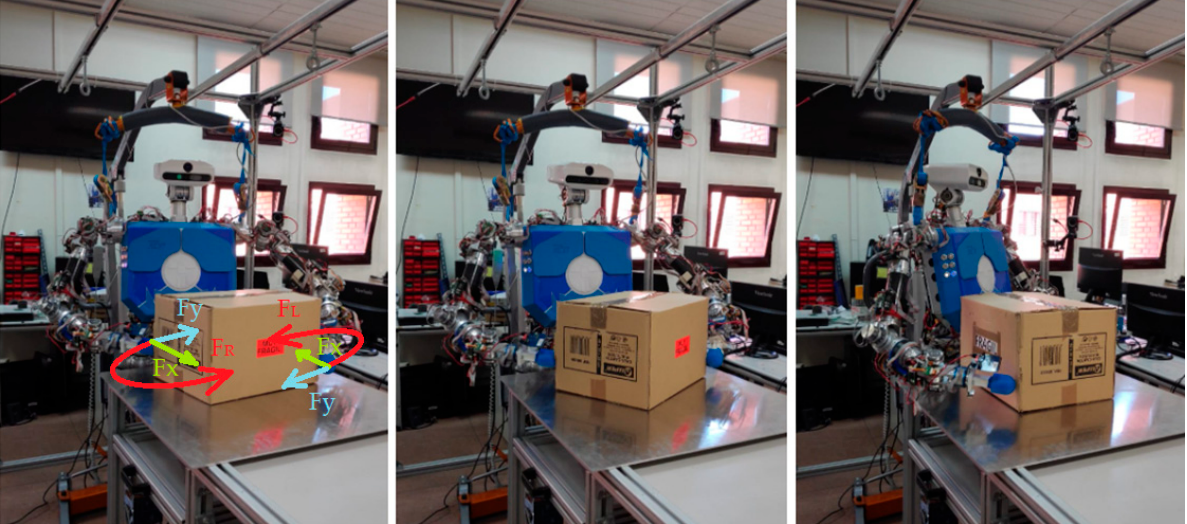
Figure 15. Humanoid robot, TEO, spinning the box over a